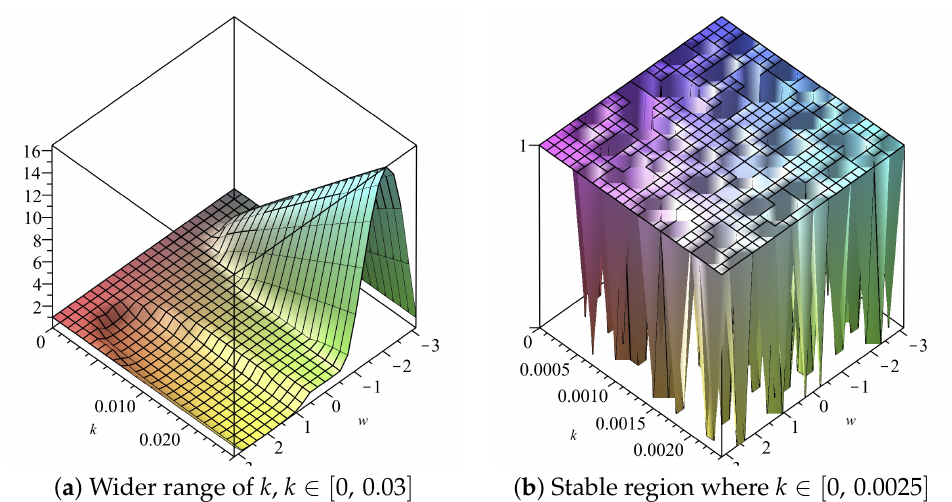
Figure 17. Plot of | ξ 2 | vs. k vs. w ∈ [ − π , π ] of Scheme 1 for Numerical Experiment 2. The spatial step size h = π /10.